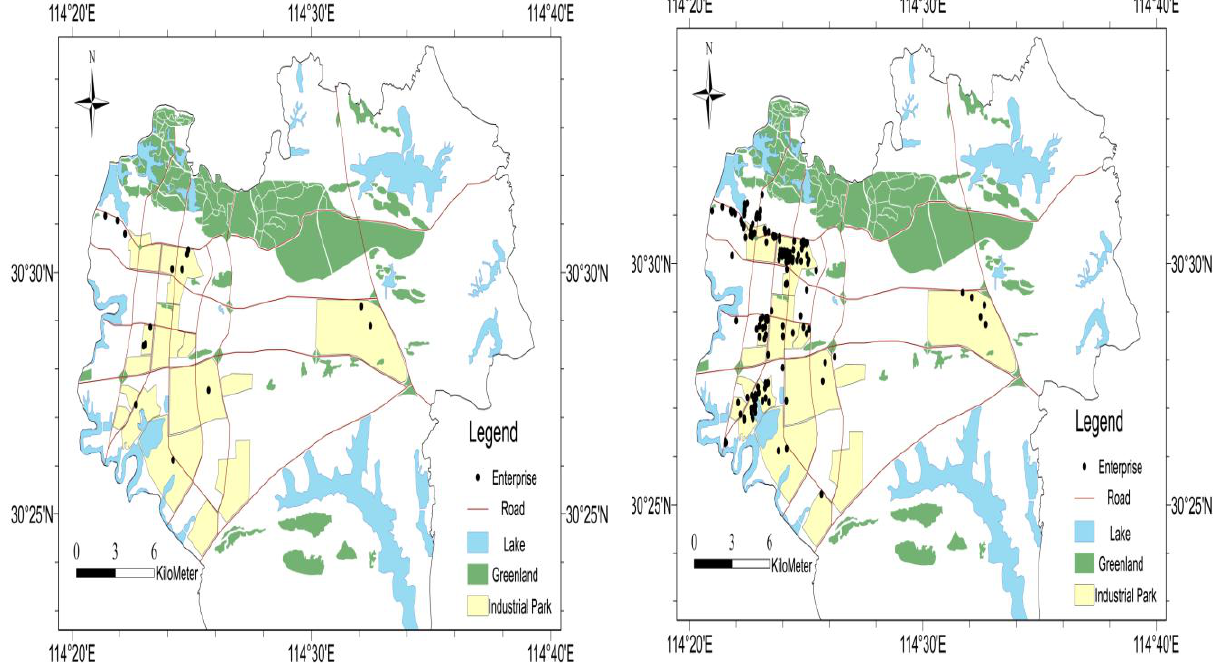
Fig. 3 Spatial distribution of enterprises in 2006